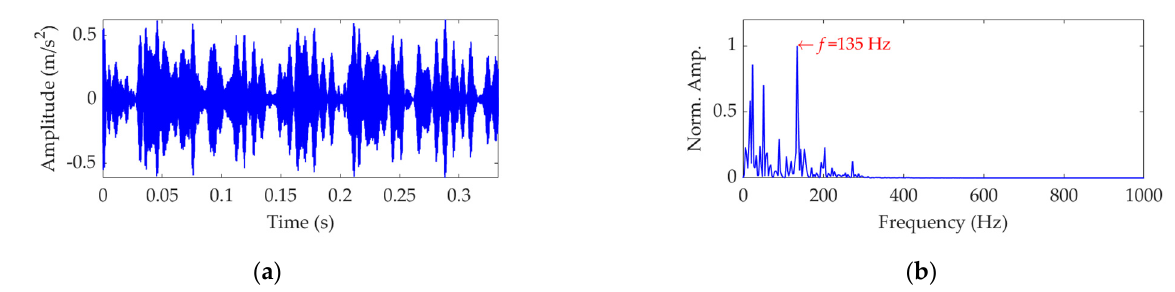
Figure 25. The EP index value of each mode.